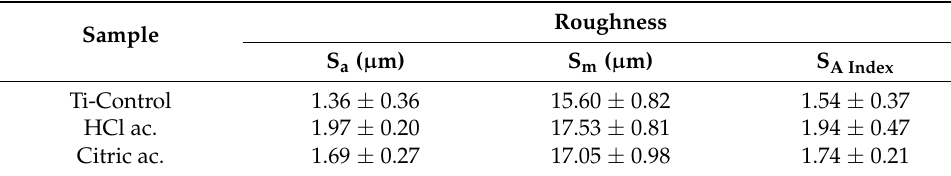
Table 2. Roughness parameters of the titanium treated